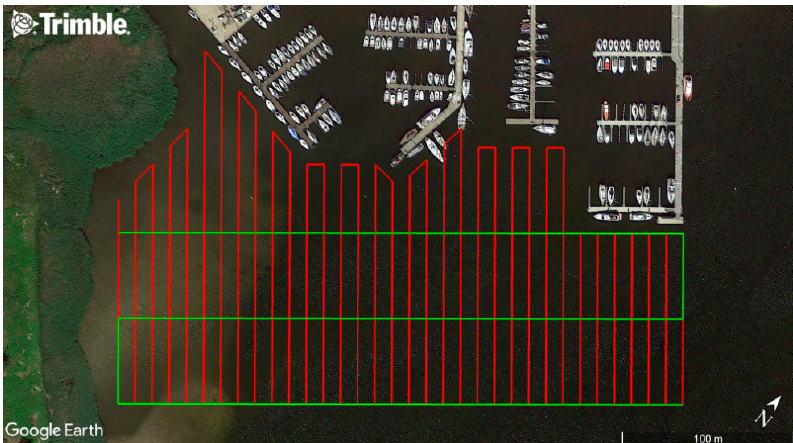
Figure 7. Designed sounding profiles in the waterbody adjacent to the National Sailing Centre at the Gda ń sk University of Physical Education and Sport (NSC-GUPES).